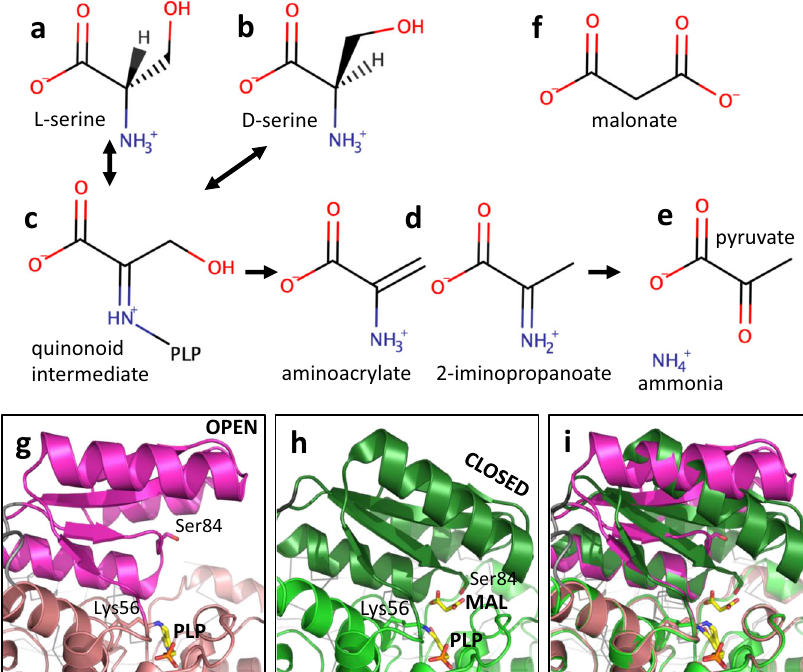
Fig. 1 Overview of serine racemase. a – e Simpli fi ed view of substrates and products in reactions catalyzed by serine racemase. Note the products, aminoacrylate and 2-iminopropanoate, are two interchangeable tautomers that will be deaminated to give pyruvate (and ammonia) in aqueous solution. f The substrate analogue inhibitor malonate. Chemical structures were drawn using MarvinSketch. g The ‘ open ’ 1.89 Å holo structure of hSR (pdb code: 6SLH). The structure is shown as a cartoon with stick representations of PLP (yellow carbons) and side-chains of Lys56 (pale pink carbons) and Ser 84 (magenta carbons). The small domain (78 – 155) is in magenta with the interdomain linker (69 – 77) in grey. The second subunit in the dimer is partially visible in the background (dark grey C α trace). h The ‘ closed ’ 1.5 Å structure of hSR with PLP and malonate (pdb code: 3L6B). Side-chains of Lys 56 and Ser 84 are shown as sticks (green carbons) as are PLP and malonate (yellow carbons). i Superposition of ( g ) and ( h ) on large